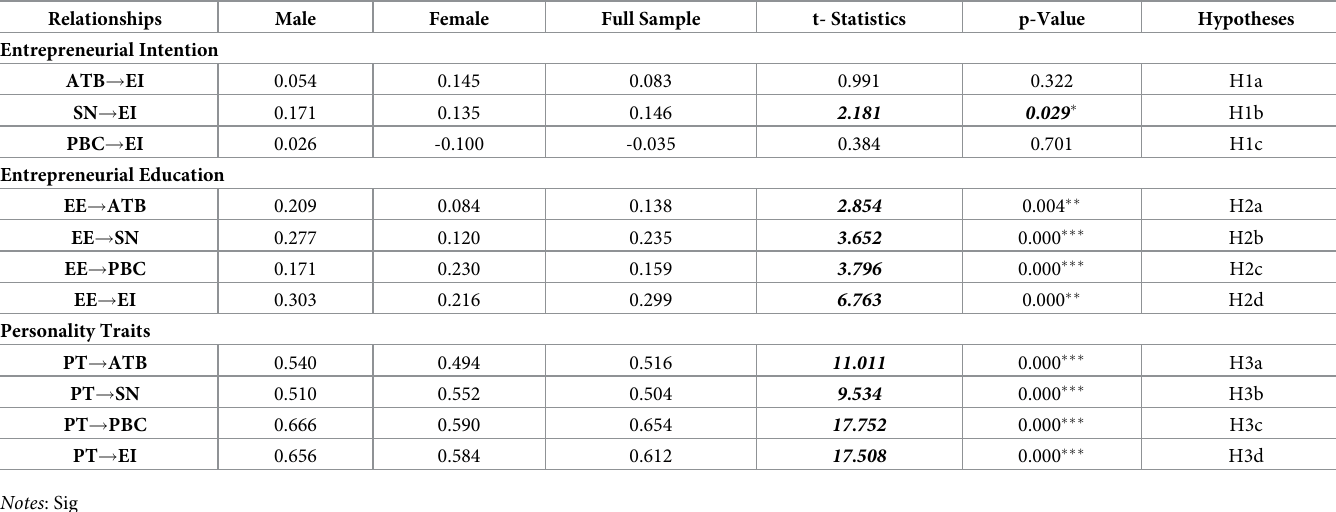
Table 4. Estimates of Path Co-efficient in a